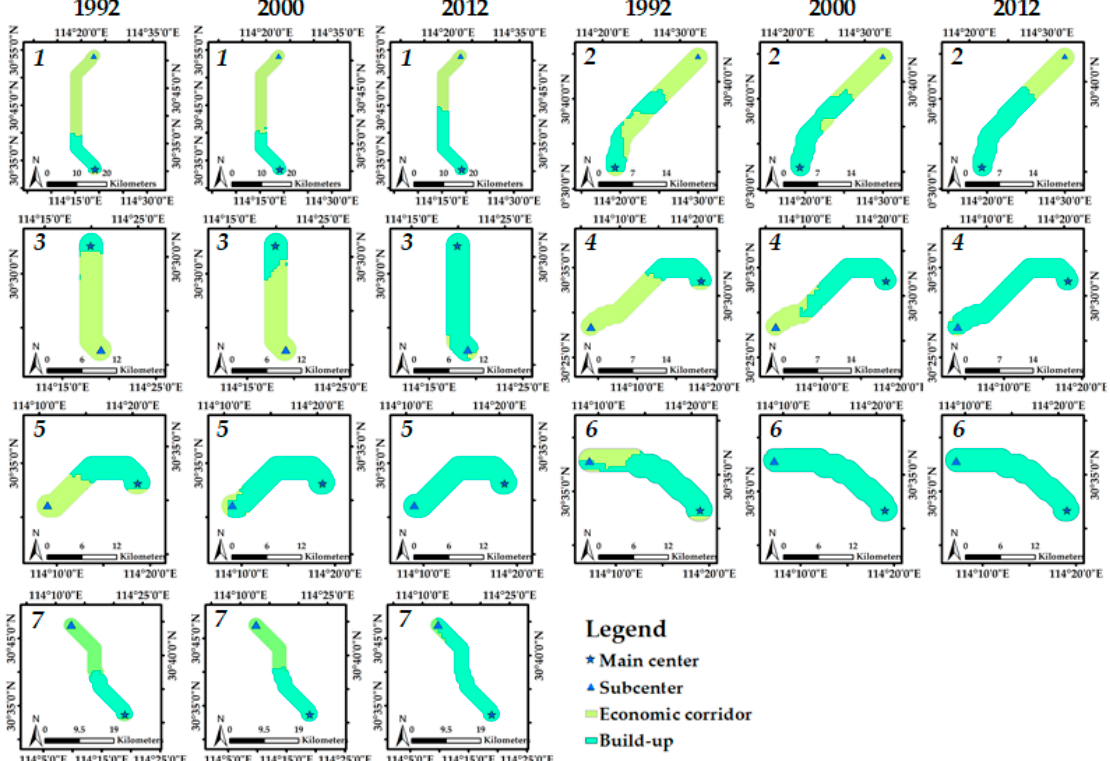
Table 5. Statistics of the built-up areas within the economic corridor for Shenyang.